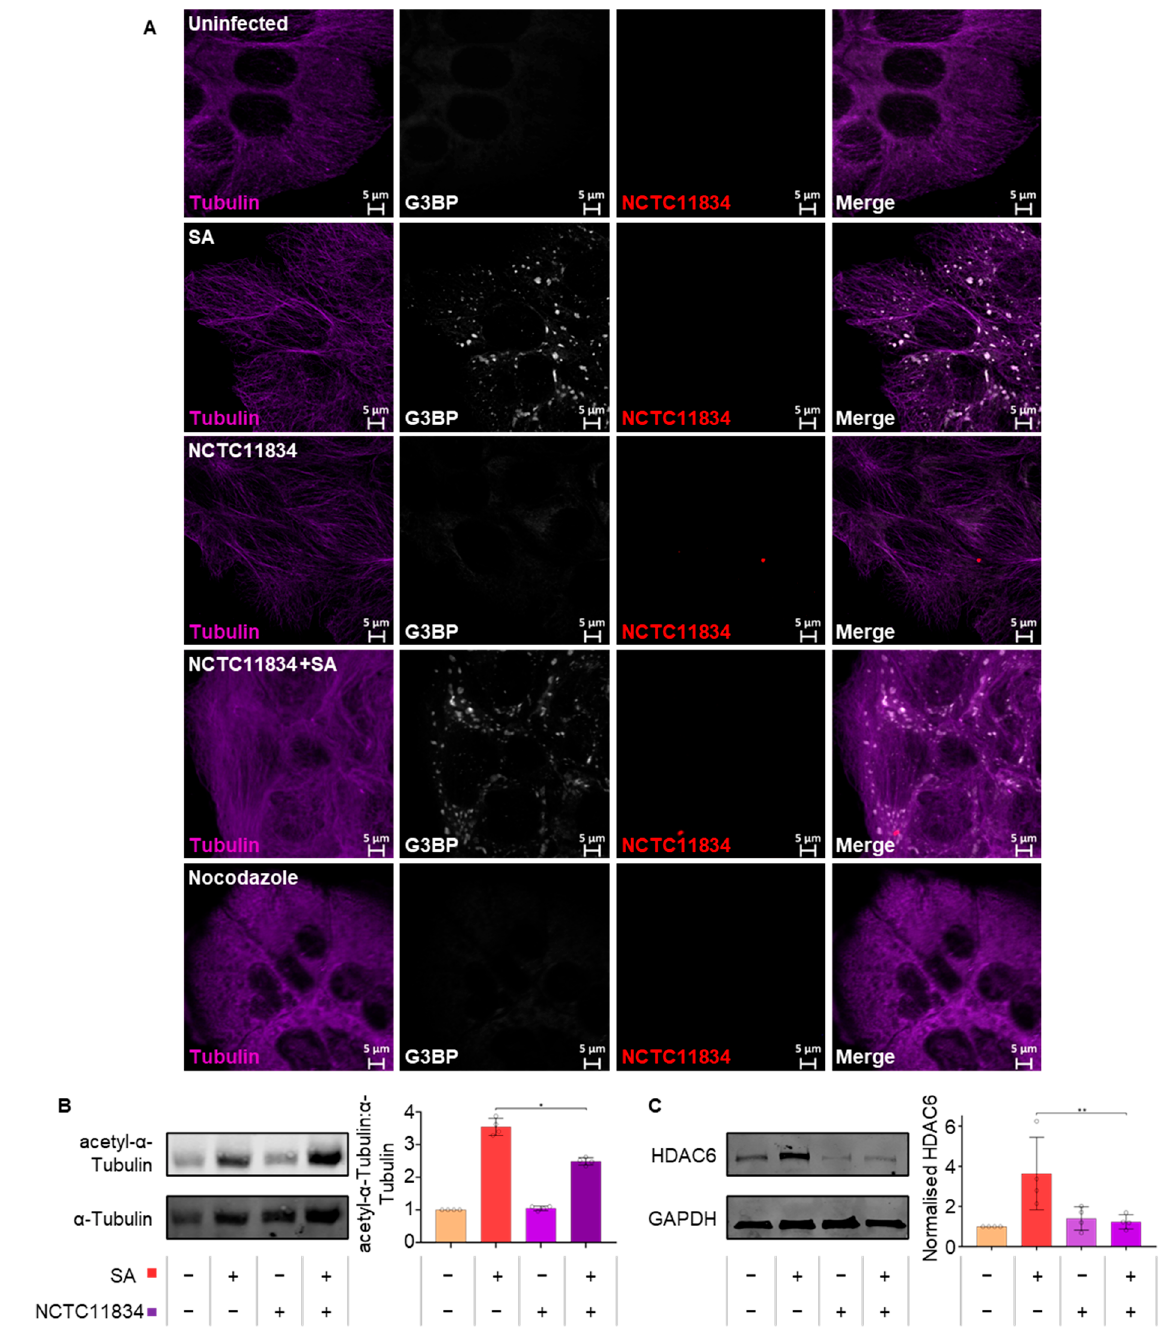
Figure 7. P. gingivalis infection dampens stress-induced tubulin acetylation. ( A ) Stress granule, α -tubulin integrity, and P. gingivalis were visualized using confocal microscopy following challenge of H357 cells with P. gingivalis (NCTC11834, MOI of 100, t = 2 h) in the presence or absence of sodium arsenite. ( B ) Expression levels of α -tubulin (left) and ratio of acetyl- α -tubulin to α -tubulin (right; mean ± SD, n = 4). ( C ) Expression of HDAC6 (left) and concentration relative to GAPDH (right; mean ± SD, n = 3) as determined by immunoblotting. **, p ≤ 0.01; *, p ≤ 0.05 according